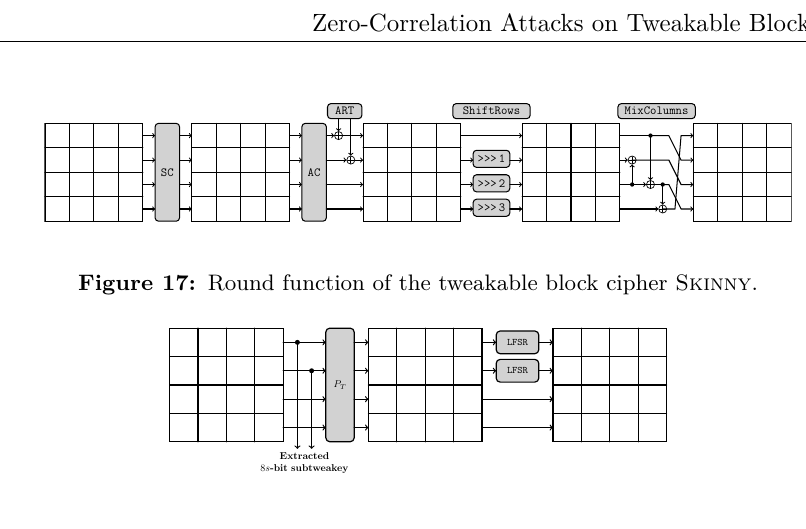
Figure 18: Tweakey schedule of Skinny